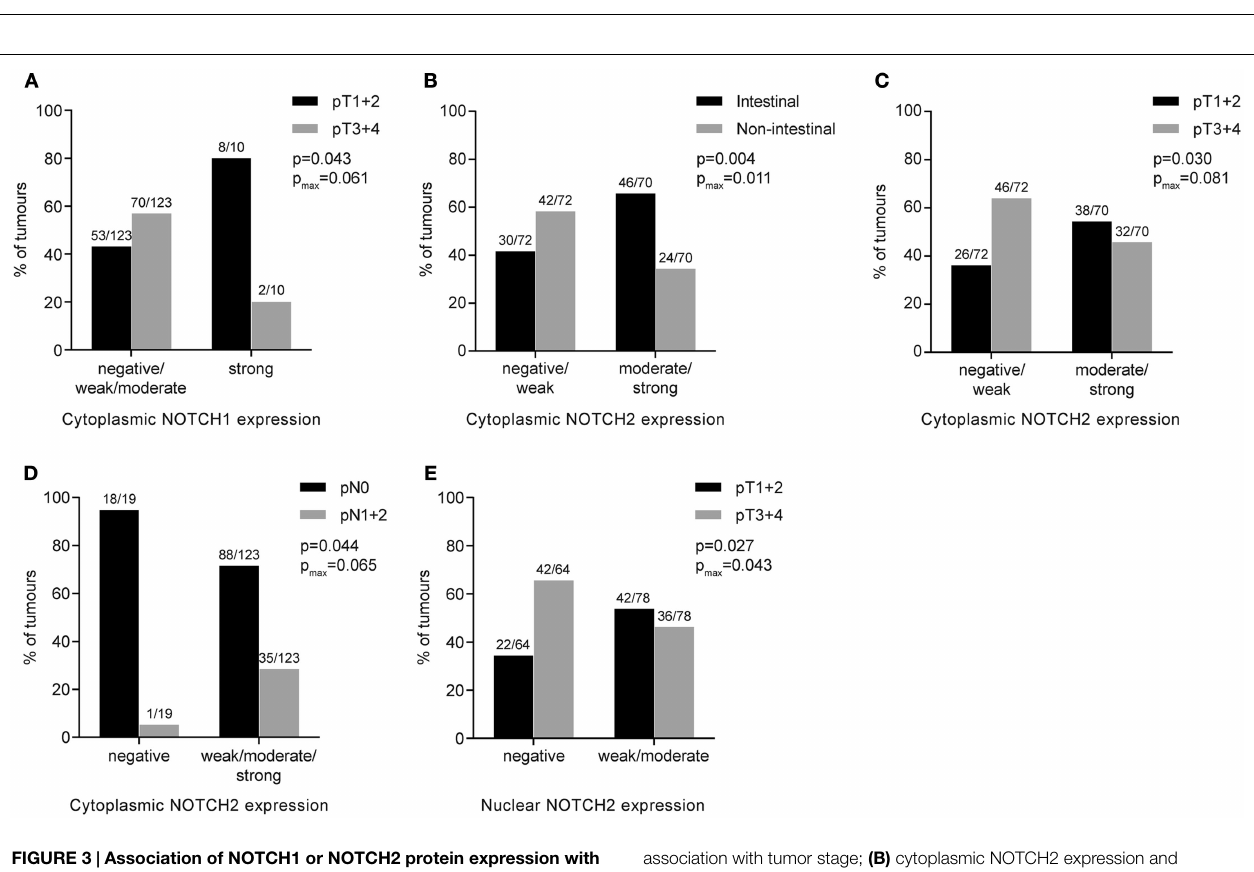
staining (SI 9) and low-intensity nuclear staining (SI 1), (F) medium-intensity cytoplasmic staining (SI 6) and low-intensity nuclear staining (SI 1); (G) low-intensity cytoplasmic staining (SI 3) and negative nuclear staining (SI 0); and (H) negative cytoplasmic and nuclear staining for NOTCH2. Scale bars: 50 µ m.